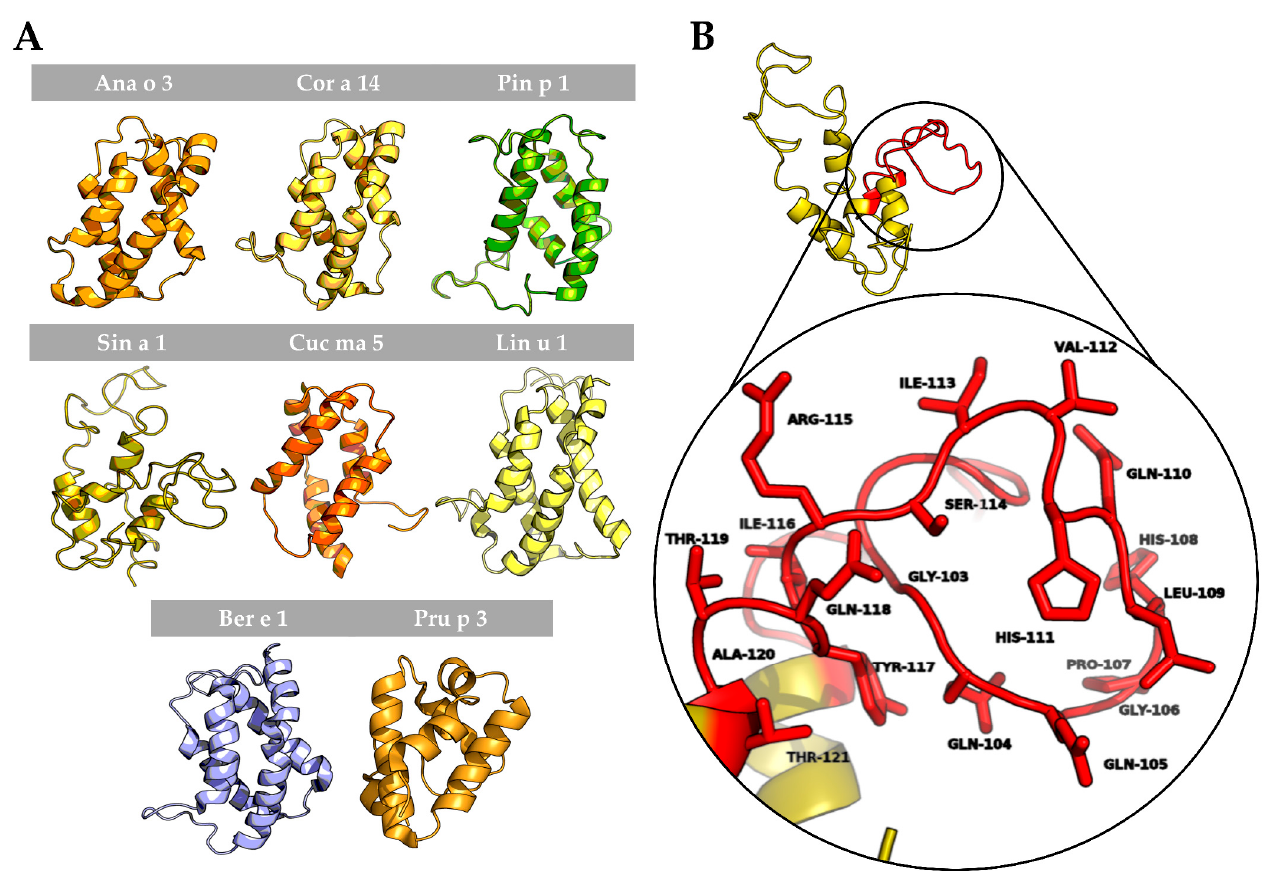
Figure 7. In silico modeling of 2S albumins three-dimensional structure. ( A ) Three-dimensional modeling of isolated 2S albumins, using the annotated structure of Ber e 1 (Brazil nut 2S albumin) as the template. nsLTP from peach, Pru p 3, has been included for comparative purposes. ( B ) Hypervariable region from mustard seed allergen, Sin a 1, and zoom into one of its allergenic epitopes located in this region.